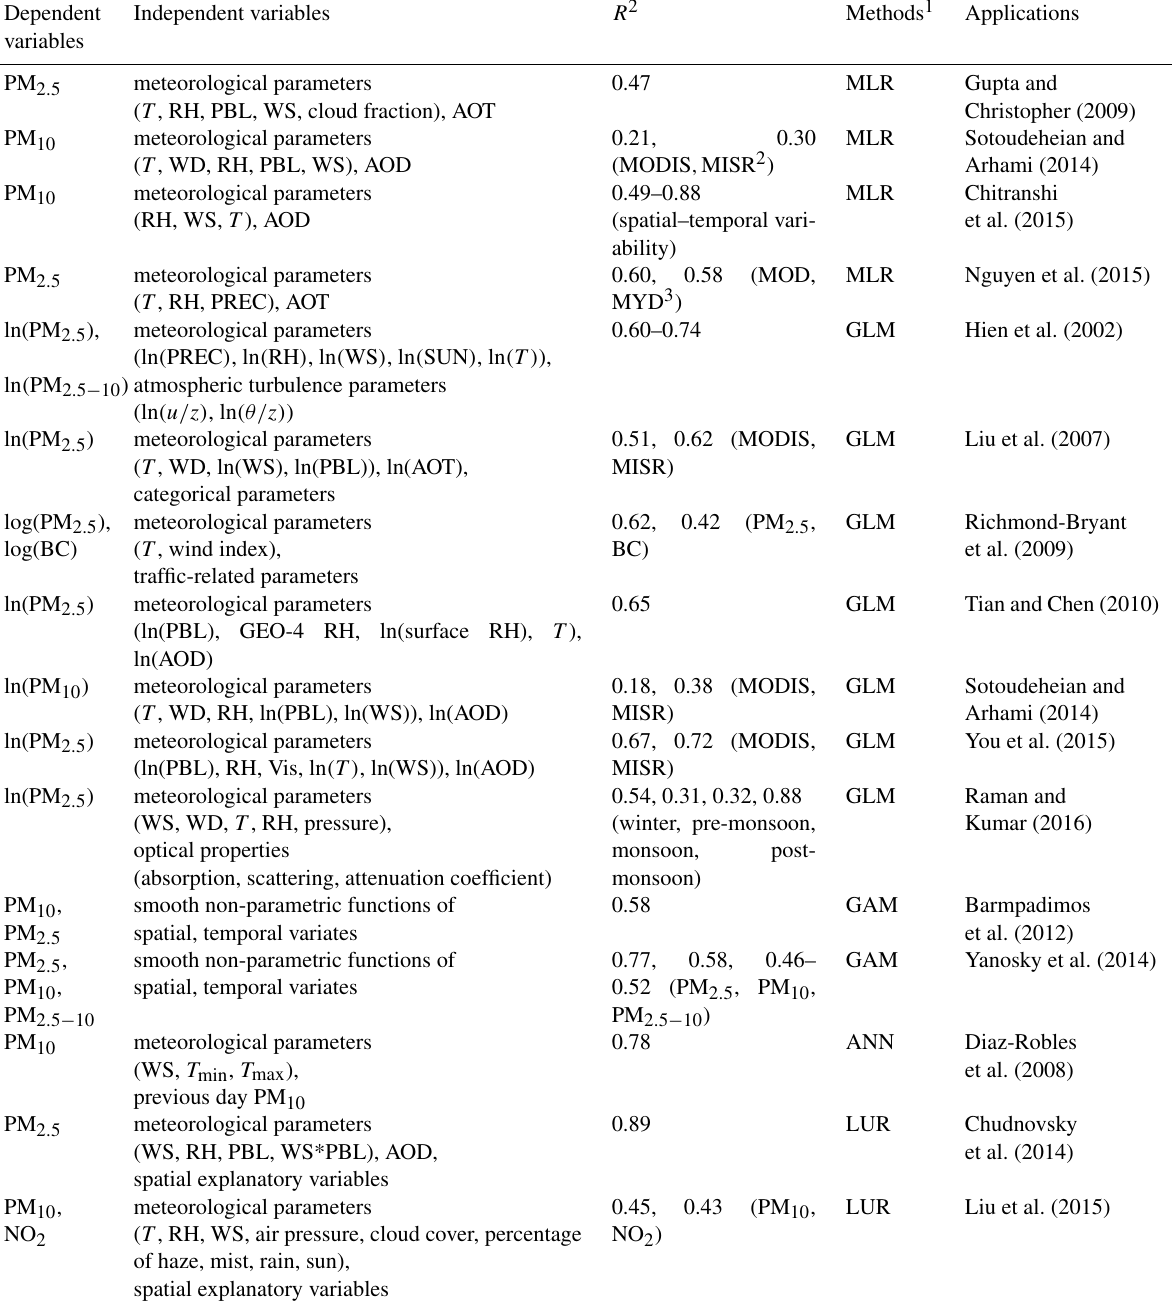
Table 1. Summary of statistical models applied to predict air pollutant concentrations with meteorological